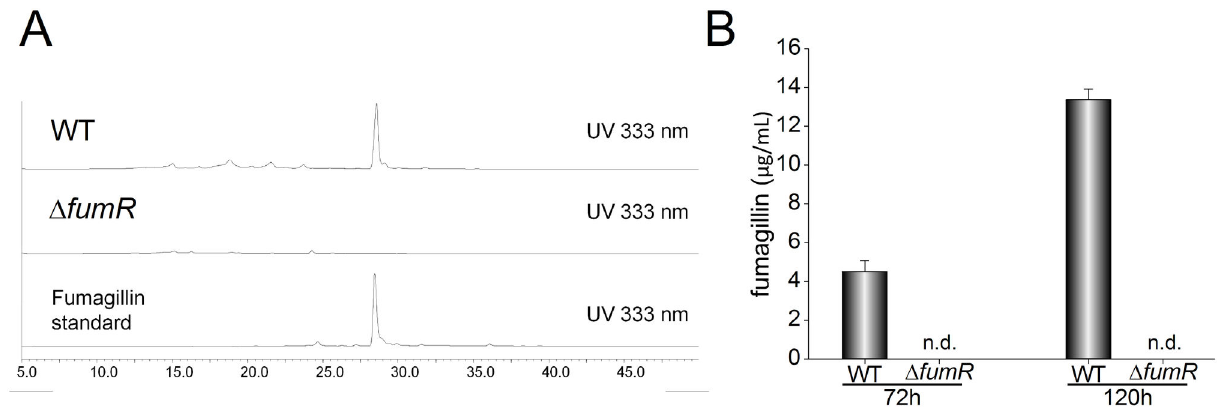
Figure 6. fumR regulates fumagillin biosynthesis. Aspergillus fumigatus wild type (WT TSD51.1) and ∆ fumR strains were grown on Czapek-Dox as stationary liquid cultures for 72 h and 120 h. Culture supernatants were extracted with chloroform and analyzed by LC-MS (A) as described in materials and methods. (B) Quantitative data of the LC-MS analysis. The experiment was done with three replicates. Error bars represent standard error. No fumagillin was detected (n.d.) in ∆ fumR mutants. A standard curve was obtained using commercial fumagillin (Sigma). doi: